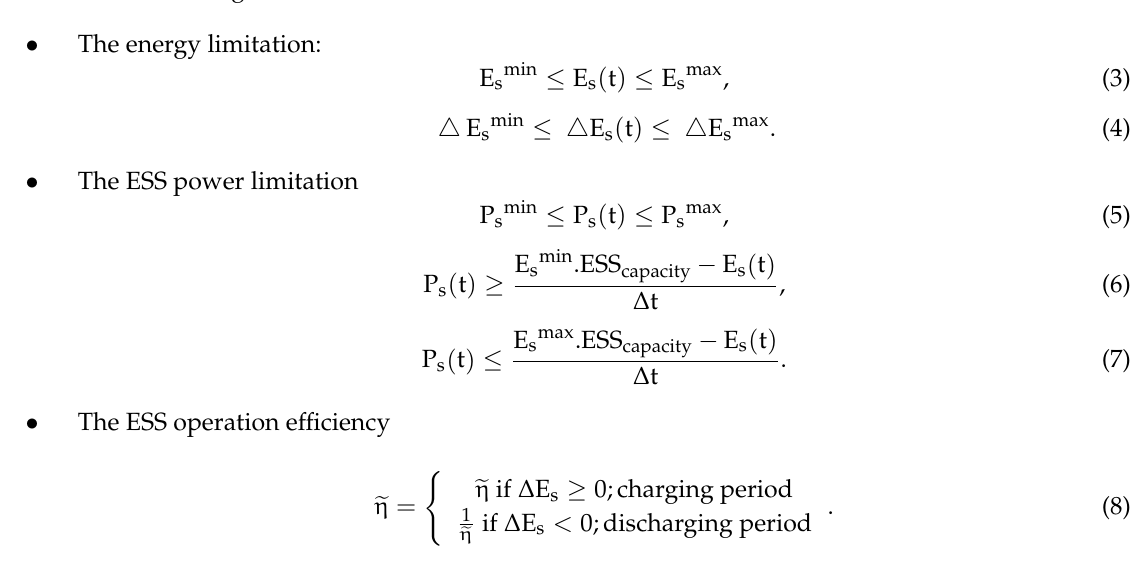
Figure 2. The power flow directions of the electrified RTG crane equipped with ESS.